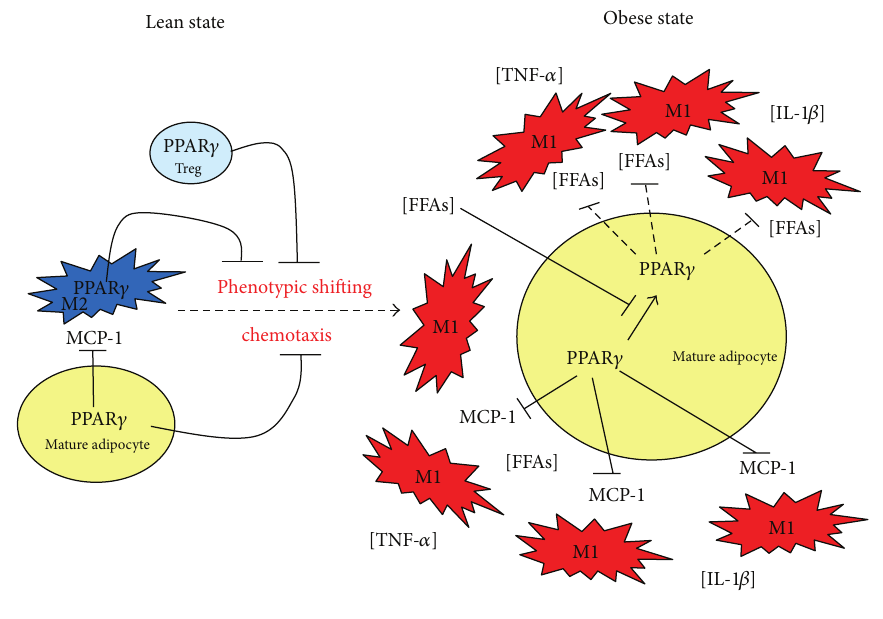
Figure 1: Contribution of the anti-inflammatory roles of PPAR 𝛾 in the onset of WAT inflammation in the context of obesity and insulin resistance. In the lean state, PPAR 𝛾 activity maintains homeostasis in mature adipocytes in preventing the secretion of chemokines such as MCP-1.Inaddition,alternativelyactivatedmacrophages(M2)andTregcellsareresidentleukocytesinWATcoordinatingnumerousbiological activities such as stimulating angiogenesis and cleaning of dead cells. The role of PPAR 𝛾 in these cells is to prevent classical activation of macrophages and local inflammation to develop. When obesity is reached, mature adipocytes are exposed to excessive concentrations of free fatty acids (FFAs), which decrease Ppar 𝛾 expression. In consequence, insulin sensitivity is also decreased in adipocytes, which elevates even more local FFAs concentrations as adipocytes are no longer able to properly store fatty acids and lipolysis also becomes activated. Furthermore, these FFAs activate macrophages shifting into an M1 phenotype, promoting the release of proinflammatory cytokines such as TNF- 𝛼 and IL-1 𝛽 . Secondly, as PPAR 𝛾 transrepressional activity is decreased, adipocytes secrete high concentrations of chemokines (MCP-1), further promoting the recruitment of macrophages. Occurrence of this feed forward amplification loop between adipocytes and macrophages eventually leads to the elevation of local inflammation, further exacerbating local insulin resistance, which will turn systemic in the long term. MCP-1: monocyte chemoattractant protein-1; treg cells: regulatory T cells; FFA: free fatty acids; PPAR 𝛾 : peroxisome proliferator-activated receptor 𝛾 ; TNF- 𝛼 : tumor necrosis factor-alpha; IL-1 𝛽 : Interleukin-1